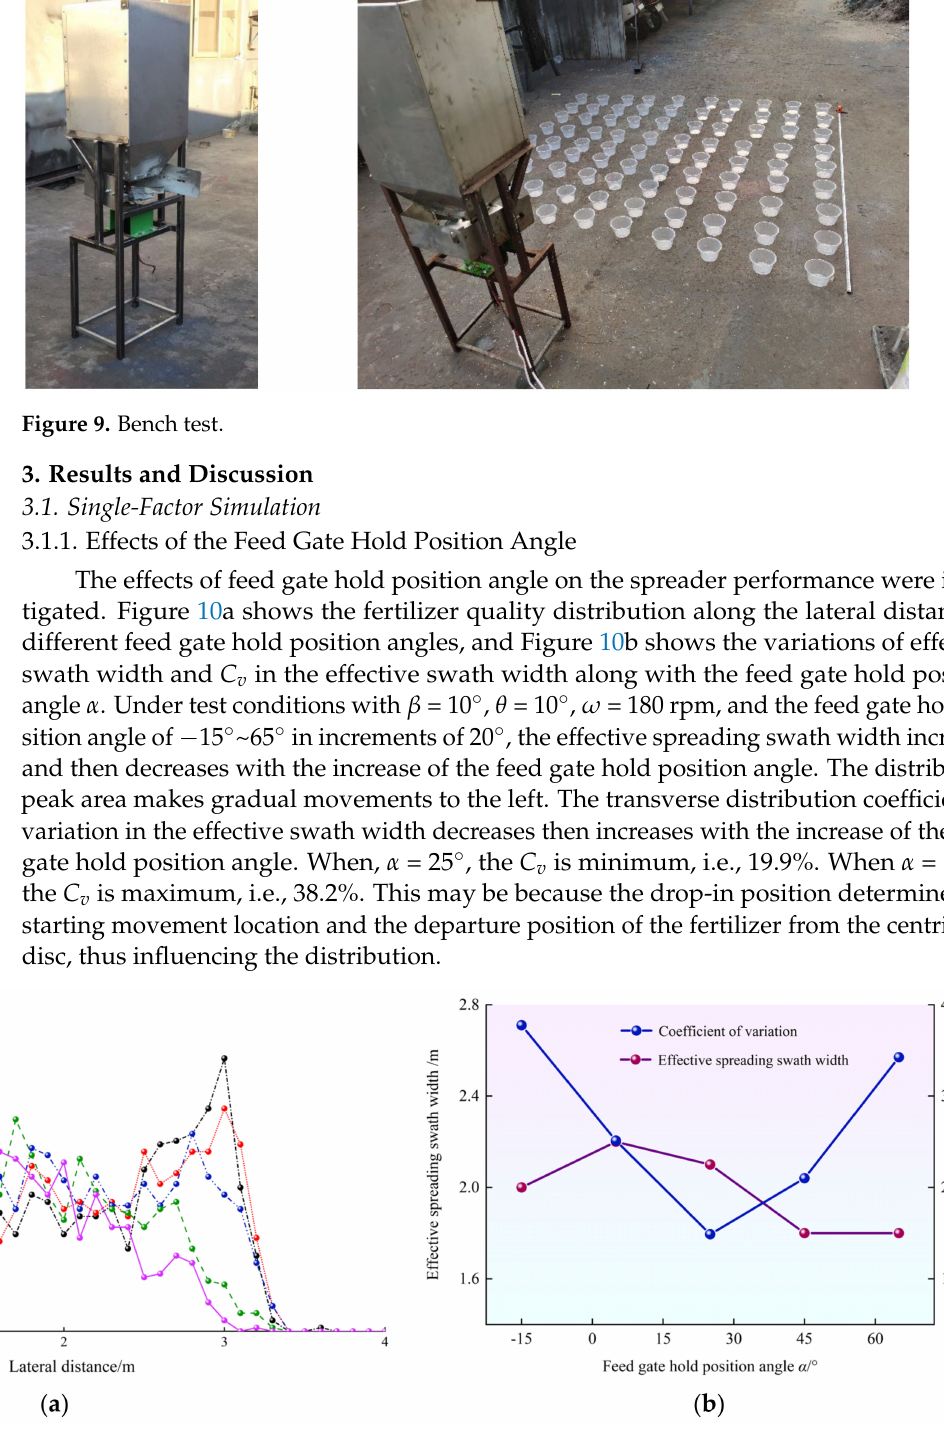
Figure 10. Effects of the feed gate hold position angle α . ( a ) Fertilizer quality distribution along with the lateral distance; ( b ) variations of effective swath width and C v along with α